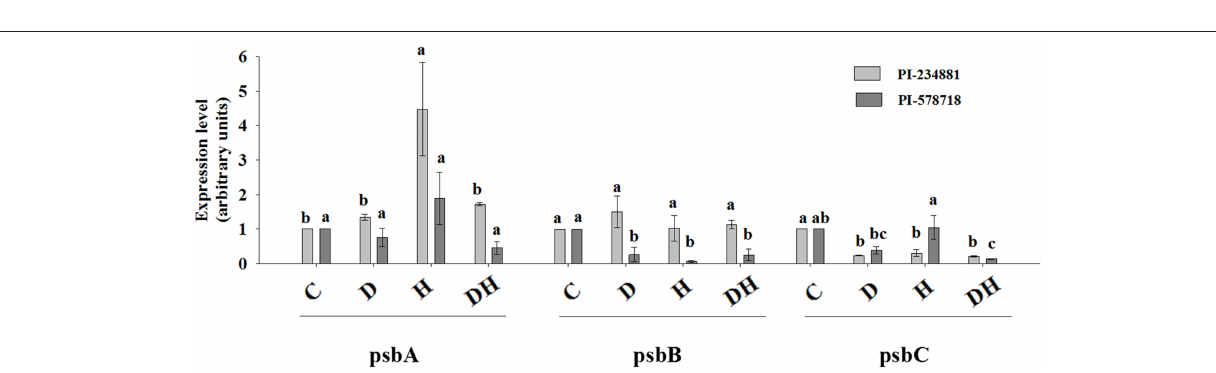
FIGURE 4 | Effect of drought (D), heat (H), combined stress (DH) on the gene transcription of tall fescue leaves. Tall fescue leaves were under water (Control), drought (D), heat (H), combined stress (DH) for 7th in the same incubator. Then tall fescue leaves were stored in liquid nitrogen for RT-PCR. Data are given as mean ± SD of three independent experiments. Different letters indicate statistical difference significance at P < 0.05 among the treatments by Duncan’s multiple range tests.